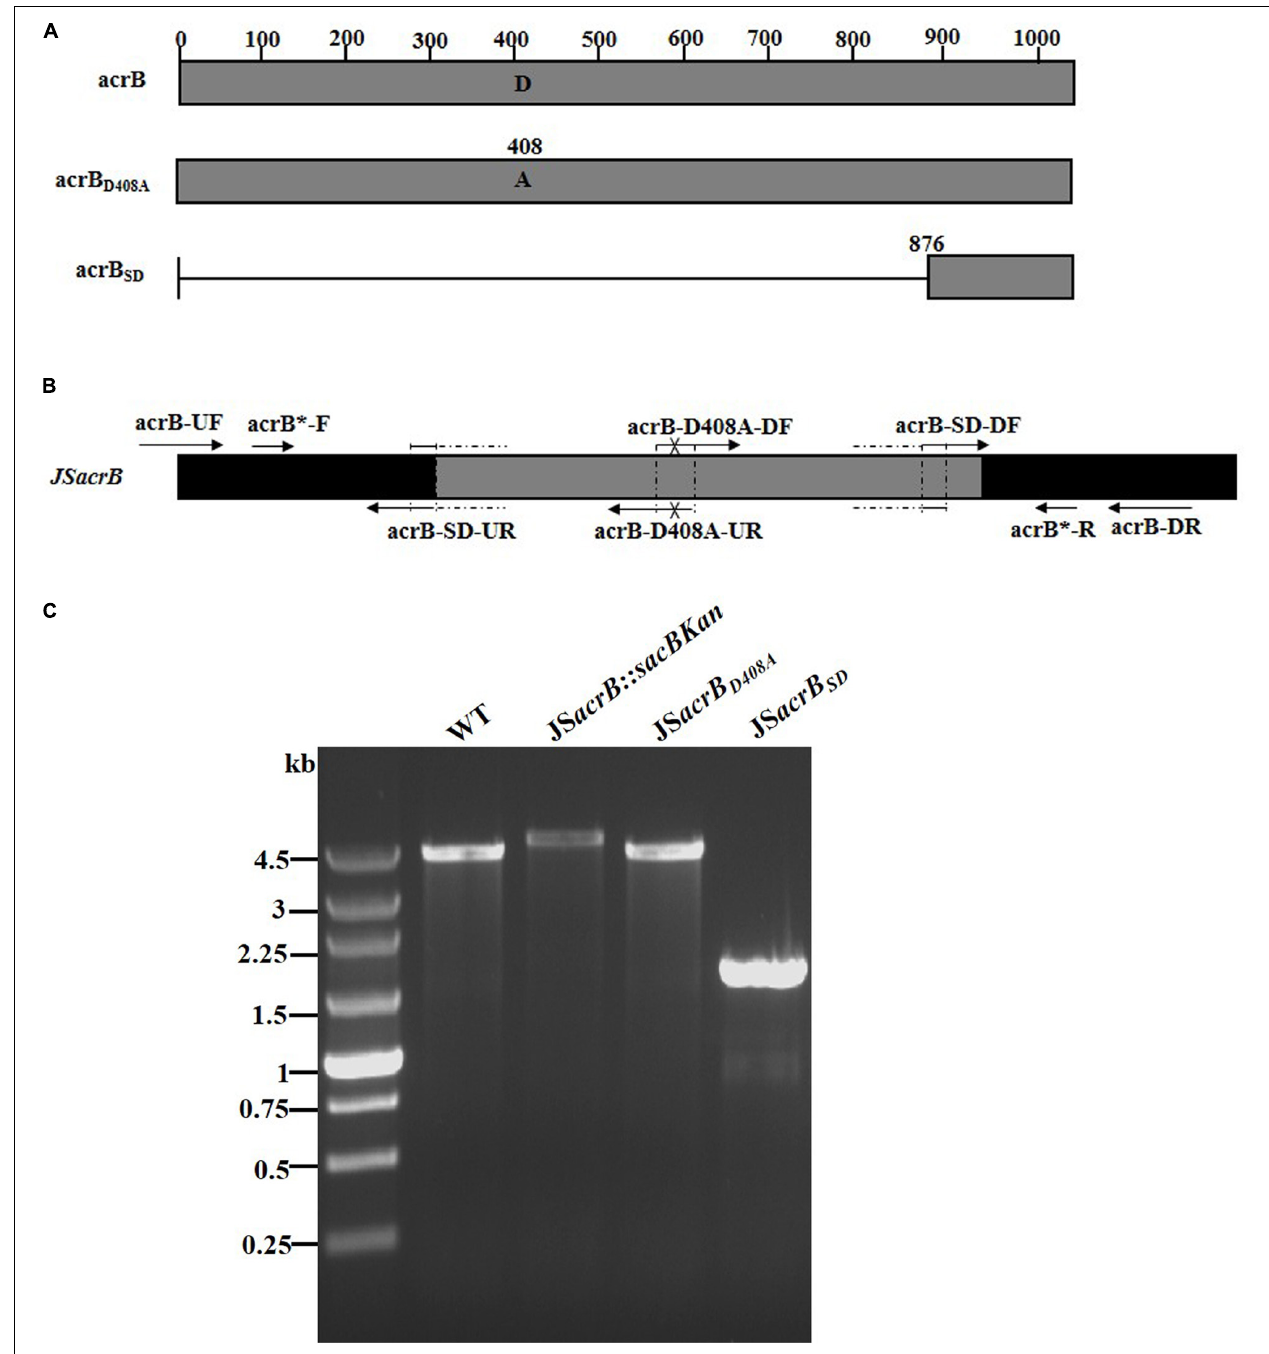
FIGURE 6 | Construction of different gene modifications of acrB gene. (A) Schematic diagram of the gene structure of different acrB gene modifications. The JS acrB D 408 A mutant includes the point mutation at the 408th amino acid (A → D) of the acrB protein. The JS acrB SD mutant was seamlessly deleted in the major region of the acrB protein. (B) Primer design for constructing the mutagenic substitution fragment. The universal primers are acrB-UF/DR and acrB-F*/R*, and the mutation primers are acrB-M408A-DF/UR and acrB-SD-DF/UR. The overlapping region of acrB-D408A-DF/UR includes the point mutation at codon 408 (GAC → GCC) of the acrB gene used to create the acrB D 408 A point mutation fragment. The overlapping region of acrB-SD-DF/UR lacks a great mass of codons (1ATG → 876CTG) used to create the acrB SD deletion mutation fragment. (C) PCR analysis of acrB multiple mutants. Band sizes: WT, 4.19 kb; intermediate strain (JS acrB : sacBKan ), 4.78 kb; final strain (JS acrB D 408 A ), 2.19 kb; final strain (JS acrB SD ), 1.56 kb. Molecular size markers (250 bp DNA ladder marker, Takara) are indicated. WT, wild